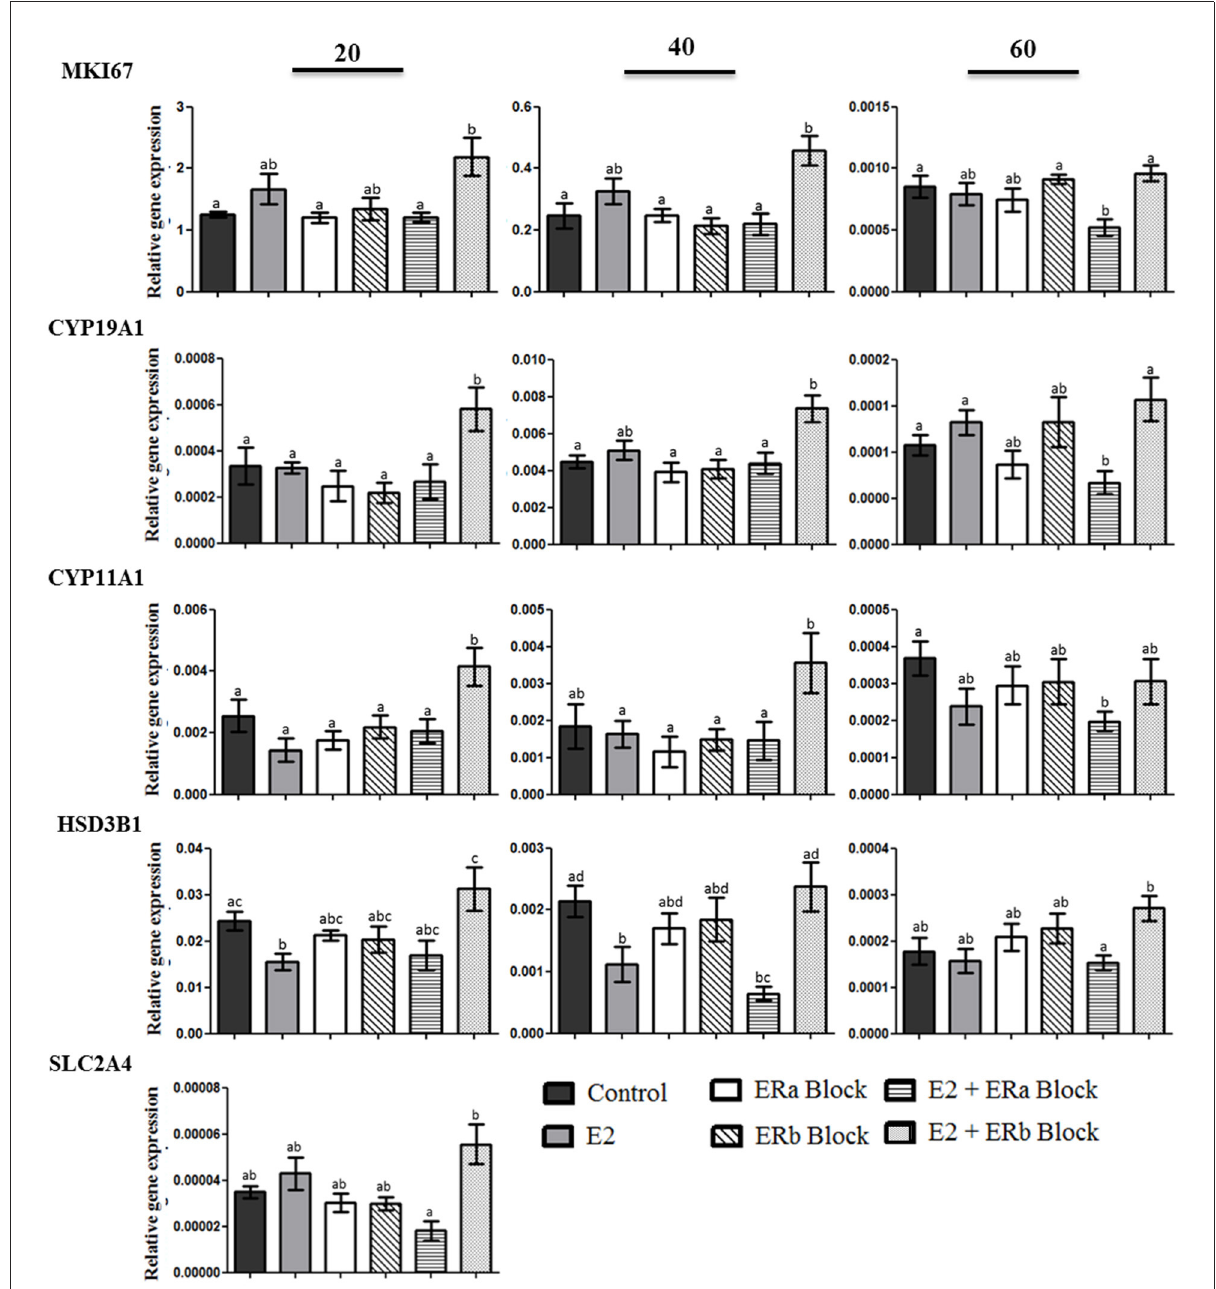
FIGURE6 Gene expression MKI67 , cytochrome P450, family 19, subfamily A, polypeptide 1 ( CYP19A1 ), cytochrome P450, family 11, subfamily A, polypeptide 1 ( CYP11A1 ), 3- β -hydroxysteroid dehydrogenase/ 1 -5-4 ( HSD3B1 ), solute carrier family 2 (facilitated glucose transporter), and member 4 ( SLC2A4 ) in luteal cells collected at 20, 40, and 60 days after ovulation in diestrous bitches. Bars indicate six different groups: Control (no treatment), E2 (treated with 100 nM E2), ERa block (treated with 10 nM methyl-piperidone-pyrazole [MPP]), ERb block (treated with 10 uM (1,5-a) pyrimidine [PHTPP]), E2 + ERa block (treated with E2 + MPP), and E2 + ERb block (treated with E2 + PHTPP). Data represent mean ± standard error of relative gene expression ( n = 4 animals/group). Bars with different letters indicate significant differences among groups ( P <